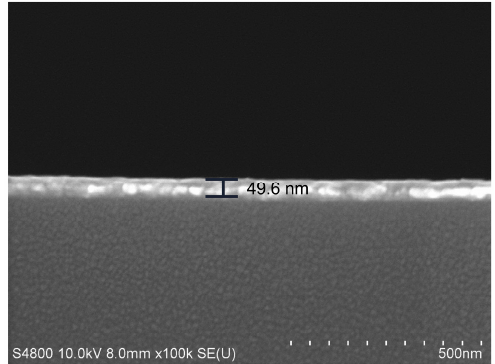
Figure 6. The SEM images of the conventional Au-based sensor.